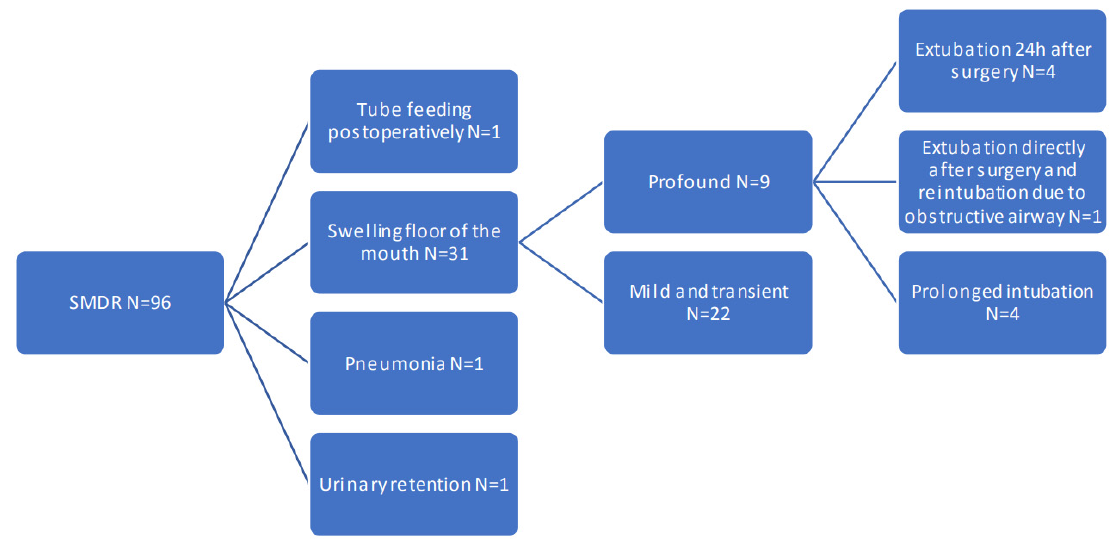
Figure 1. Complications. Tree graph of complications after